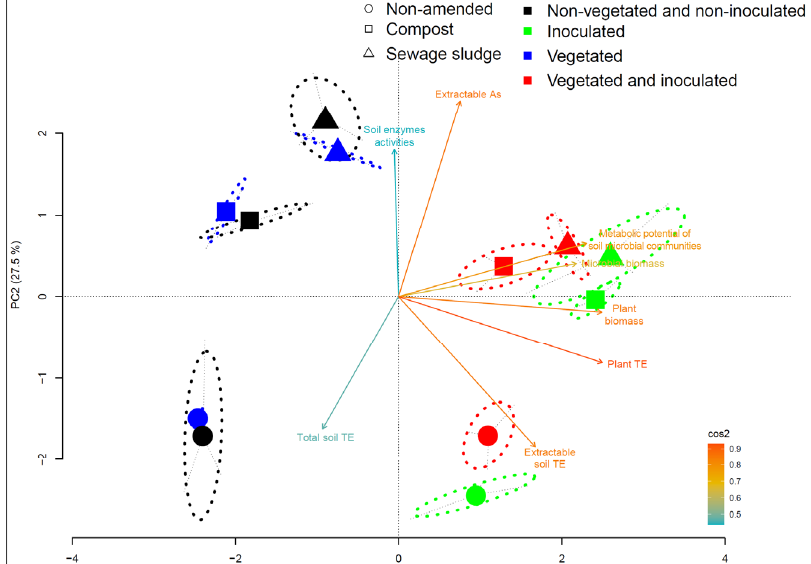
Figure 3. Principal component ordination of all of these parameters (microbial biomass, plant biomass, TE extractable concentration in soil, total TE concentration in soil, TE concentration in shoots, and soil enzymes’ activities) in the different modalities (non ‐ amended or amended with compost or with sewage sludge, AMF inoculation (NI or I), and cultivation conditions (non ‐ vegetated or vegetated).